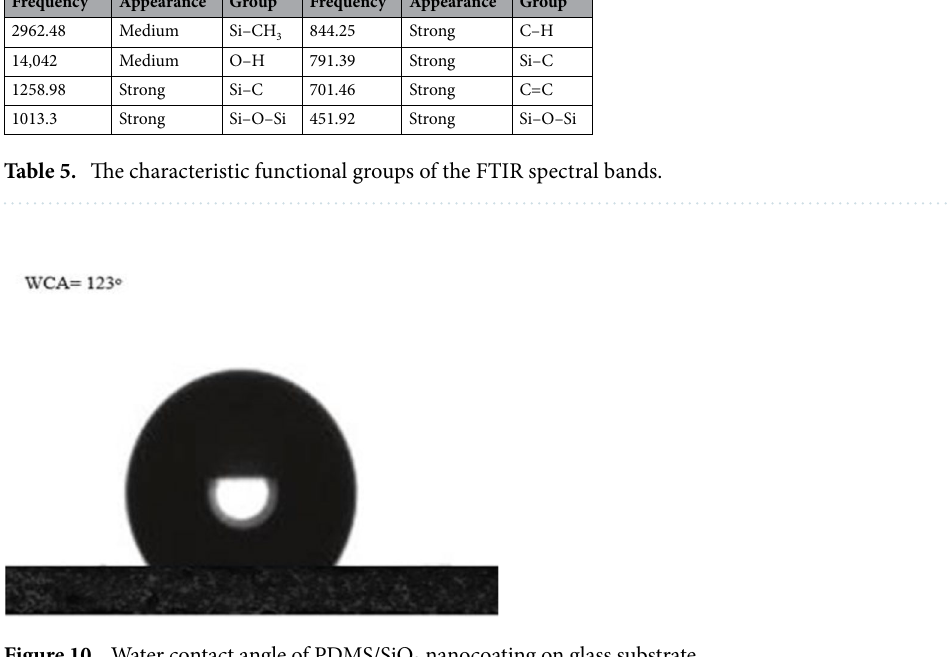
Figure 10. Water contact angle of PDMS/SiO 2 nanocoating on glass substrate.